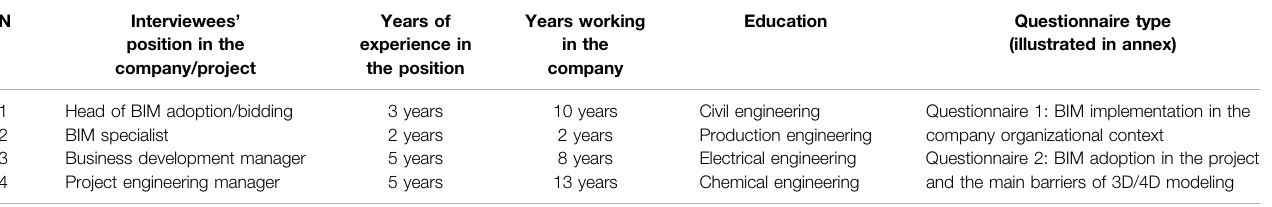
TABLE 1 | Description of the